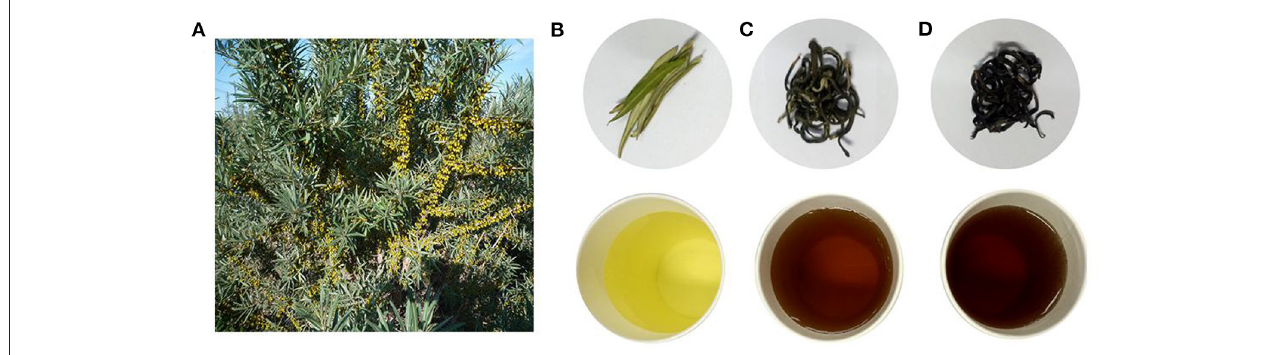
FIGURE 1 | Pictures of sea buckthorn leaves tea. (A) Hippophae rhamnoides L. (sea buckthorn). (B) Sea buckthorn leaves (SL). (C) Sea buckthorn leaves green tea (SGT). (D) Sea buckthorn leaves black tea (SBT) (top, dry leaves; bottom, tea